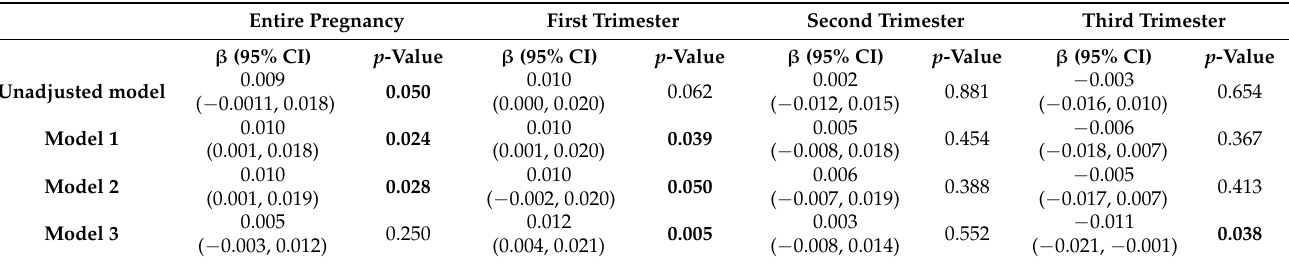
Table 5. Maternal supplemental vitamin D intake during the first, second, and third trimester and entire pregnancy and average relative TL of the newborn.